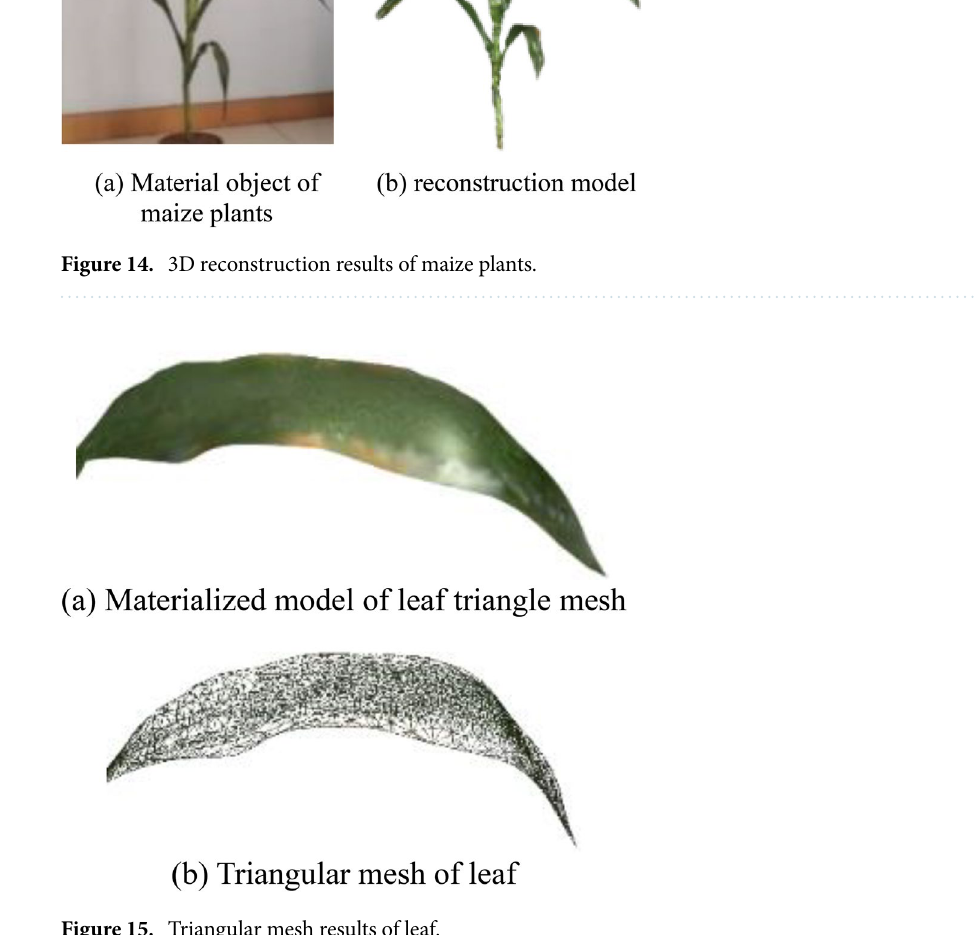
Figure 15. Triangular mesh results of